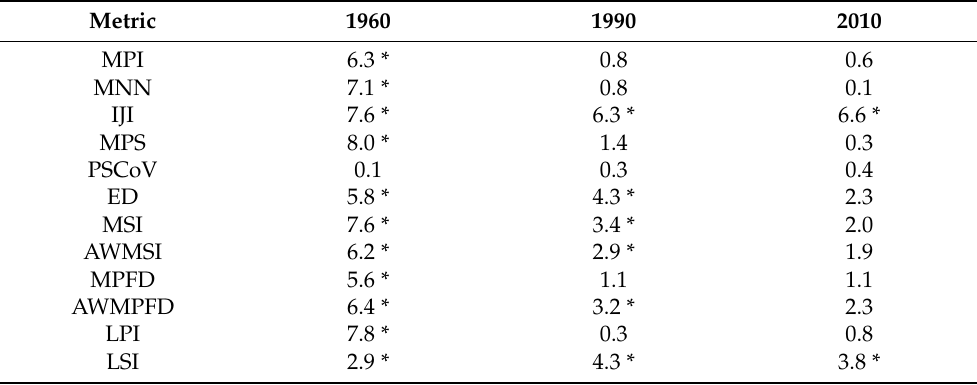
Table 3. Results of a non-parametric Kruskal–Wallis analysis of variance ( z -score) testing significant (*) differences ( p < 0.05 after Bonferroni’s correction for multiple comparisons) in selected metrics among the three ESAI classes (non-affected, fragile, critical) in Italy, by year (landscape diversity metrics were not calculated at the class scale). Metric 1960 1990 2010 MPI 6.3 * 0.8 0.6 MNN 7.1 * 0.8 0.1 IJI 7.6 * MPS 8.0 * PSCoV